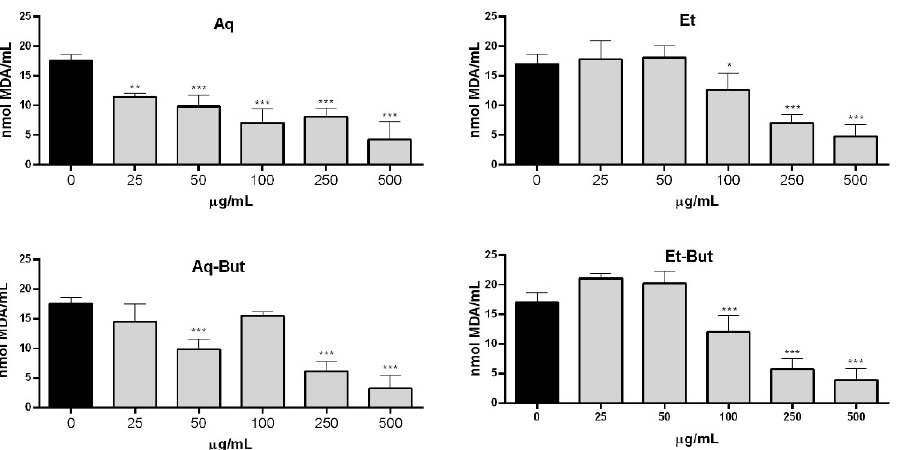
Figure 6. Analysis of the antioxidant effects of M. albicans extracts on lipid peroxidation induced by iron. Aqueous (Aq) and ethanol (Et) extracts, as well as their n -butanol fractions (Aq-But, Et-But), were tested at 25–500 µg/mL. Statistical analyses were performed by one-way analysis of variance (ANOVA), followed by Bonferroni’s test, for selected pairs. Results represent the mean ± SD of two independent experiments ( n = 2, in quadruplicate); * p < 0.05, ** p <0.01, *** p < 0.001 versus control (0).